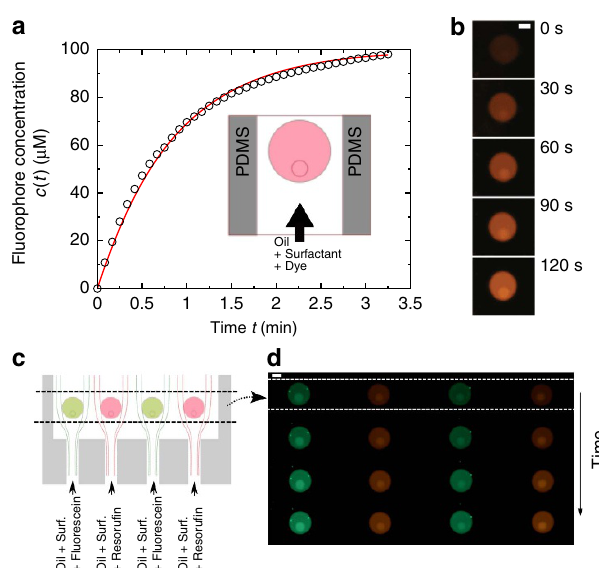
Figure 5 | Flow-induced targeted delivery. ( a ) A droplet trapped in a microchannel is exposed to an oil doped with fluorescent dye (see inset). ( b ) The partitioning to the droplet leads to an increase of fluorescence (scale bar, 40 m m). The rate of molecule uptake by the droplet is given by the delivery rate from the oil ( Q oil ¼ 0.2 m lmin (cid:2) 1 ). The principle for a controlled uptake of multiple dyes is shown in c . ( c ) Droplets of 100 m m in diameter are trapped in a microfluidic chamber. We selectively inject fluorescent dyes (fluorescein and resorufin) from the oil and surfactant mixture into the droplet. The dye injected depends on the position of the droplet in the chamber. ( d ) Experimental realization: fluorescent micrograph of the droplets showing the dye uptake occuring at a time scale of the order of 1min. Here Q oil ¼ 0.2 m lmin (cid:2) 1